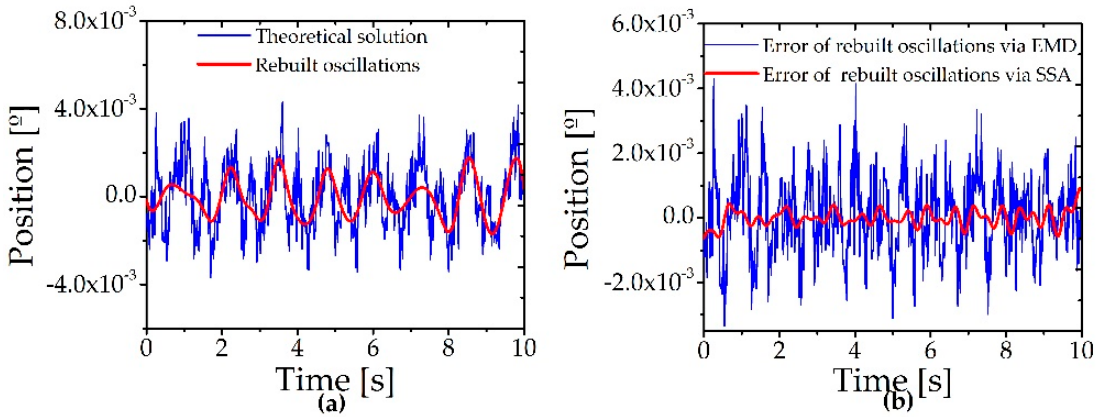
Figure 8. ( a ) Reconstruct trend, ( b ) reconstruct oscillations ( c ) error of rebuilding oscillations and trend via SSA in the